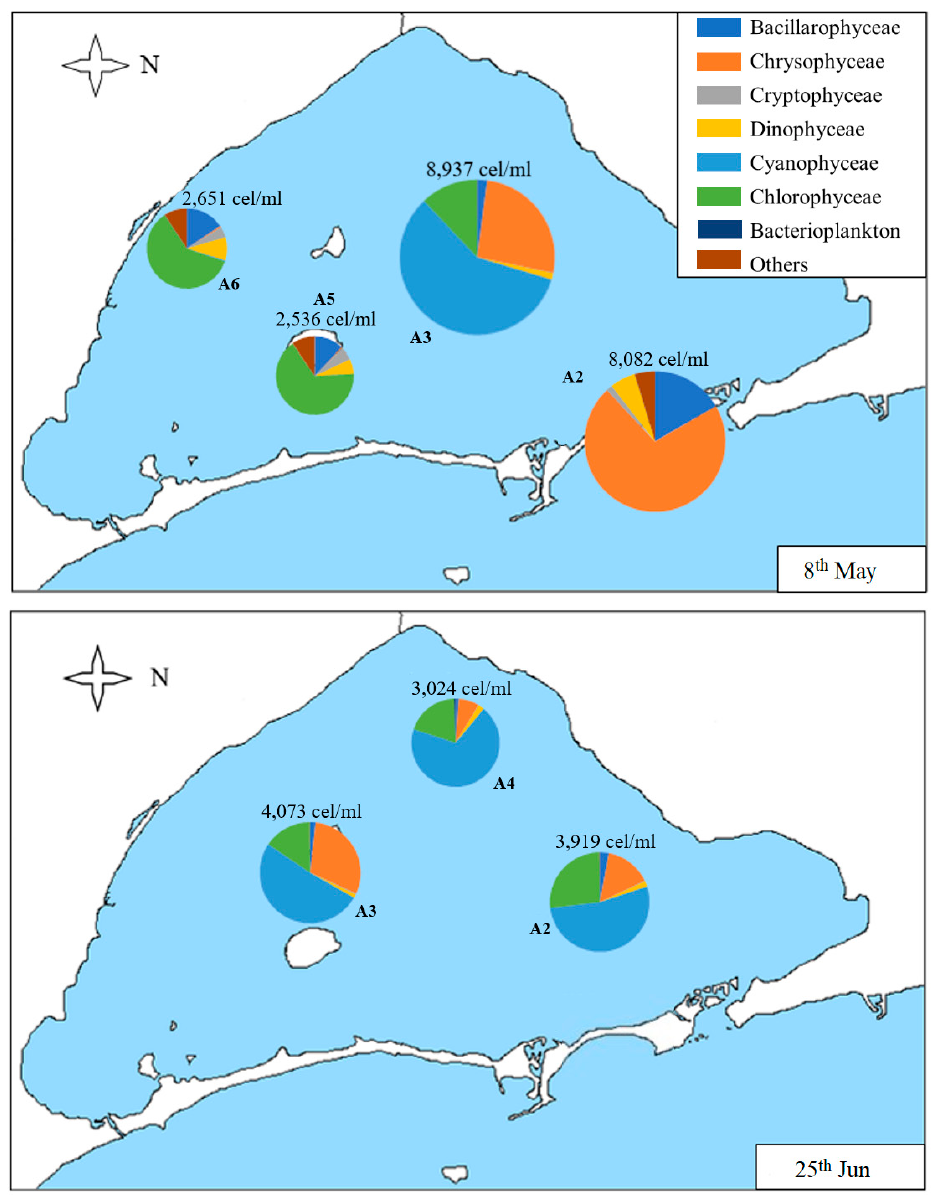
Figure 5. Map of the Mar Menor lagoon with the density graphs of the di ff erent classes of phytoplankton found in each sample on 8th May and 25th June. The total density of the sample is annotated on each graph. “Others” includes the classes Conjugatophyceae, Pedinophyceae, Euglenophyceae, Diphylleida, and Thecofilosea, which appear in very low